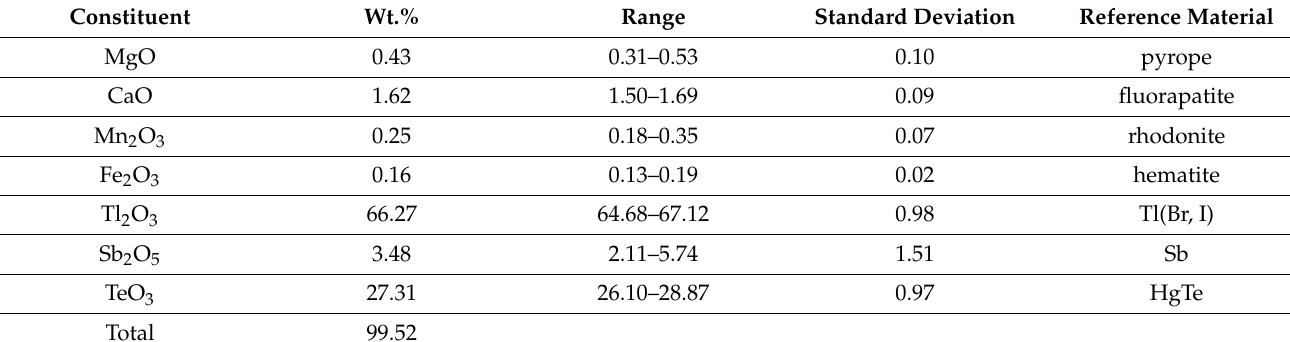
Table 2. Chemical data for